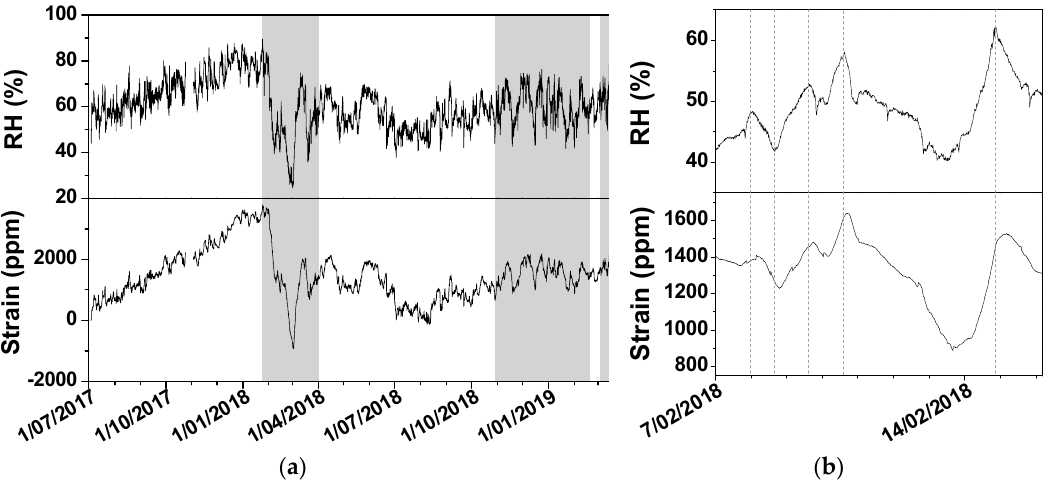
Figure 6. ( a ) relative humidity and wood strain in the period 3 July 2018 inside a Belgian church. The periods with heating are marked in grey. ( b ) detail for the period 3 July 2018. Visual indication with dashed lines to demonstrate variable shift between RH and strain data.